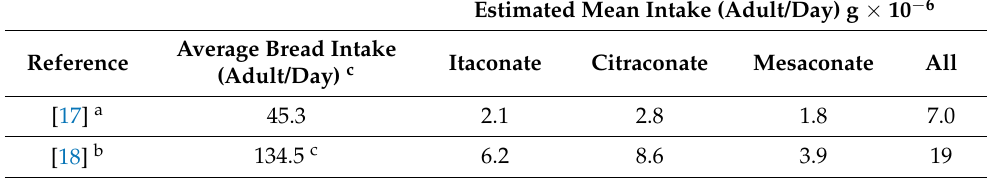
Table 1. Comparison of calculated amounts of all analytes per slice of bread (g × 10 − 6 ± SD). Table 2. Estimated daily intake of itaconate isomers in bread. Bread Type